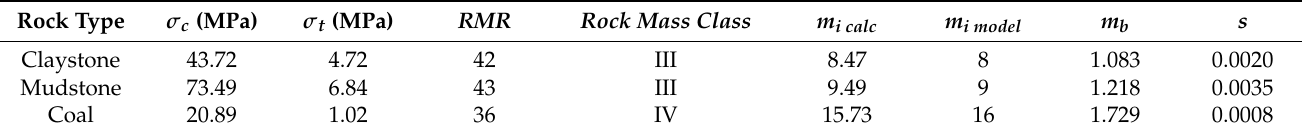
Table 4. Parameters of rocks around roadway